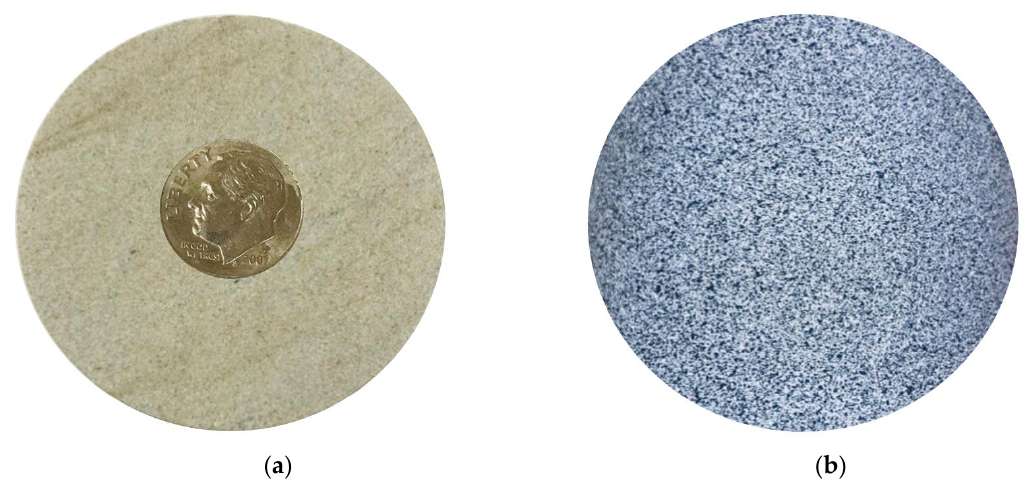
Figure 2. Specimen for Brazilian testing. ( a ) Brazilian disc sample; ( b ) painted Brazilian disc.